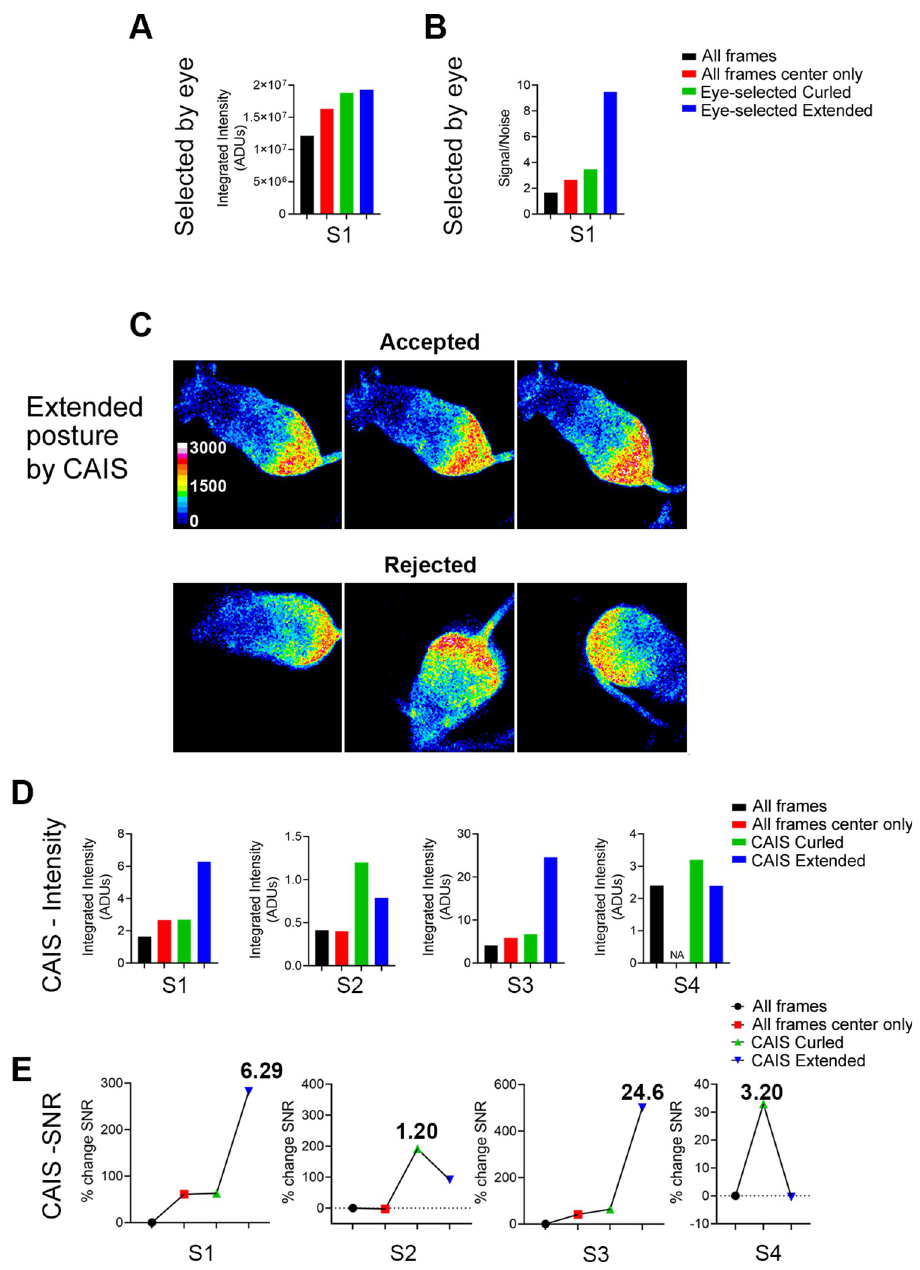
Fig 4. Improved signal-to-noise ratios of bioluminescence in Hr-Per1 mice after selection for body position and posture. A: Average integrated intensity of frames in the entire time series segment S1 (All frames) is shown with three subgroups: after selection for frames with center-of-mass of intensity within the image central quadrant (center only) and in two subgroups of image frames selected by eye according to two body postures (curled and extended). Measured intensity increased in the three derived subgroups. B: Signal-to-noise ratio (SNR) increased several-fold in the subgroups relative to the All frames (full frame) group. C: Images of a freely moving mouse given oral luciferin and selected by computer-aided image selection (CAIS) as meeting criteria for the extended posture (accepted) or not (rejected). Some frames chosen through CAIS were also detected among the eye-selected images, for example top row, right and Fig 2, top row, middle. D: Integrated intensity (ADUs divided by 10 7 ) of images from the same time series segment and three more grouped by computer-aided image selection (CAIS) based on average object roundness for the two eye-selected groups. E: SNR increased overall. S1, S2, and S4 were collected from mice given oral luciferin. S3 is the same mouse as in S1 but given injected rather than oral